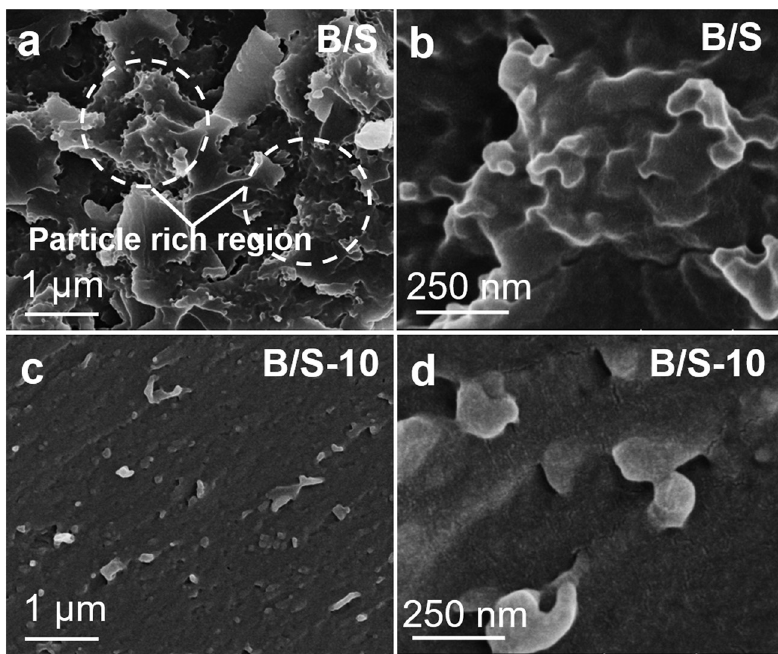
Figure 10: SEM micrographs of fracture surfaces of cured epoxy - B/S ( a and b ) and epoxy - B/S - 10 ( c and d ) composites after tensile